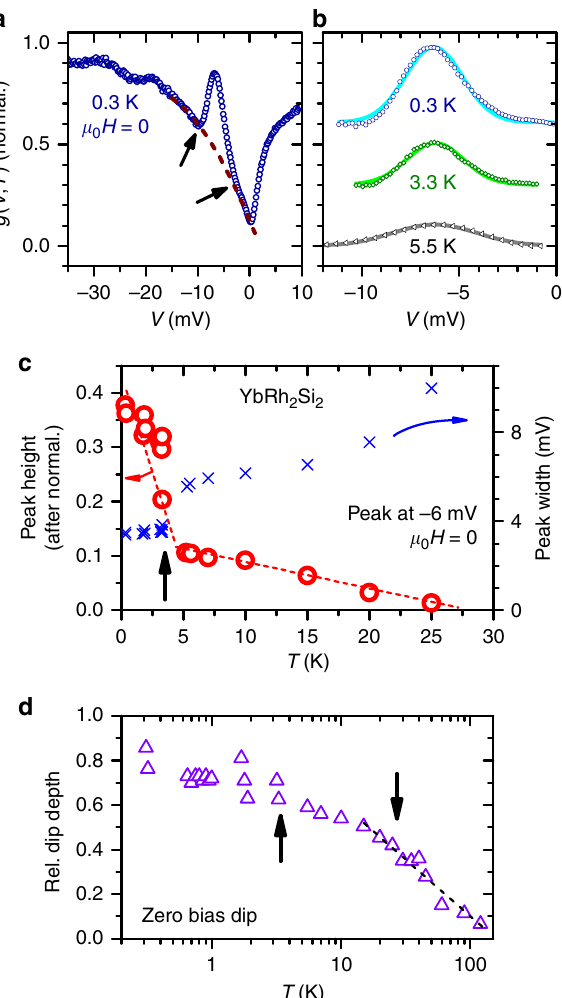
Fig. 3 Analysis of the Kondo lattice peak. a Tunneling conductance g ( V , T = 0.3 K) normalized to its value at V = − 80 mV, and parabola used for background subtraction (dashed line). Arrows indicate onset of deviations between data and parabola. b Examples of g ( V , T , H = 0)-data after background subtraction (hollow markers, data sets at T < 5.5 K are offset). Data can be well described by Gaussians (lines). c Height (circles) and width (FWHM, crosses) of the peak at − 6 mV after normalizing all g ( V , T )- curves at − 80 mV. At T P , indicated by the upward arrow, peak height and width change signi fi cantly. Results from different samples cause several markers to overlap. Dashed lines are guides to the eye. d Relative depth of the single-ion Kondo dip at zero-bias. Low- T data were obtained on several surfaces of two different samples, data at T ≥ 5 K from ref. 7 . The upward arrow indicates T P (as in c ), the downward arrow T K . Dashed line is a logarithmic fi t to the data as proposed in ref.